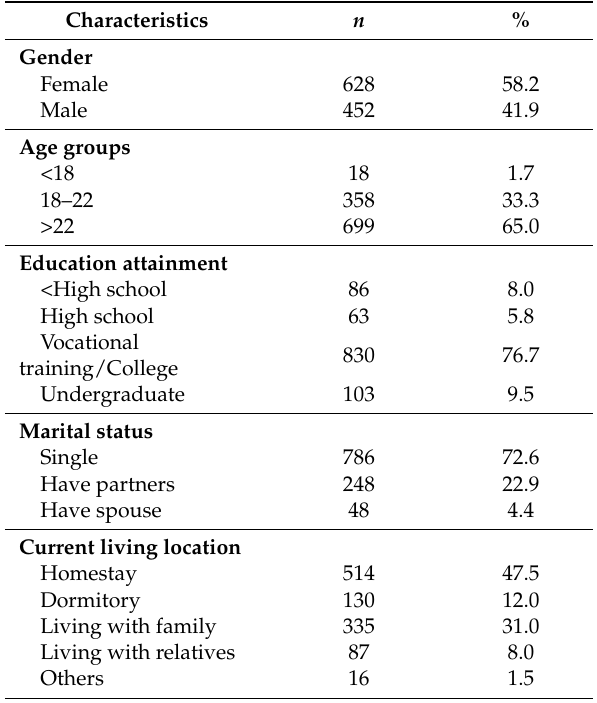
Table 1. Demographic characteristics of internet respondents ( n = 1082).